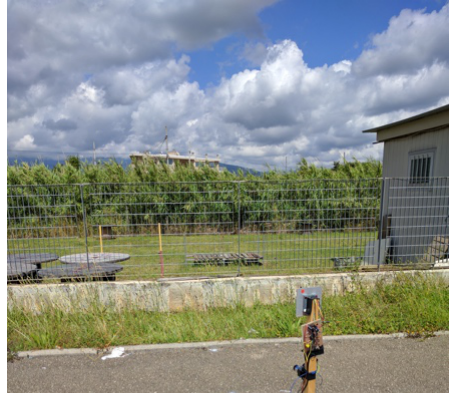
Figure 16. Metal Net, experimental setup